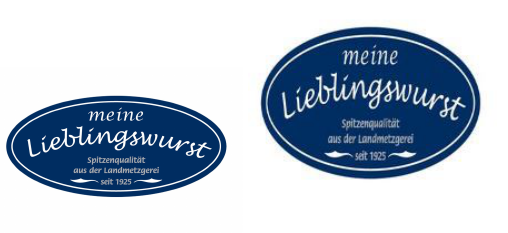
Figure 2. The process of resizing an image may affect its contents if original resolutions are